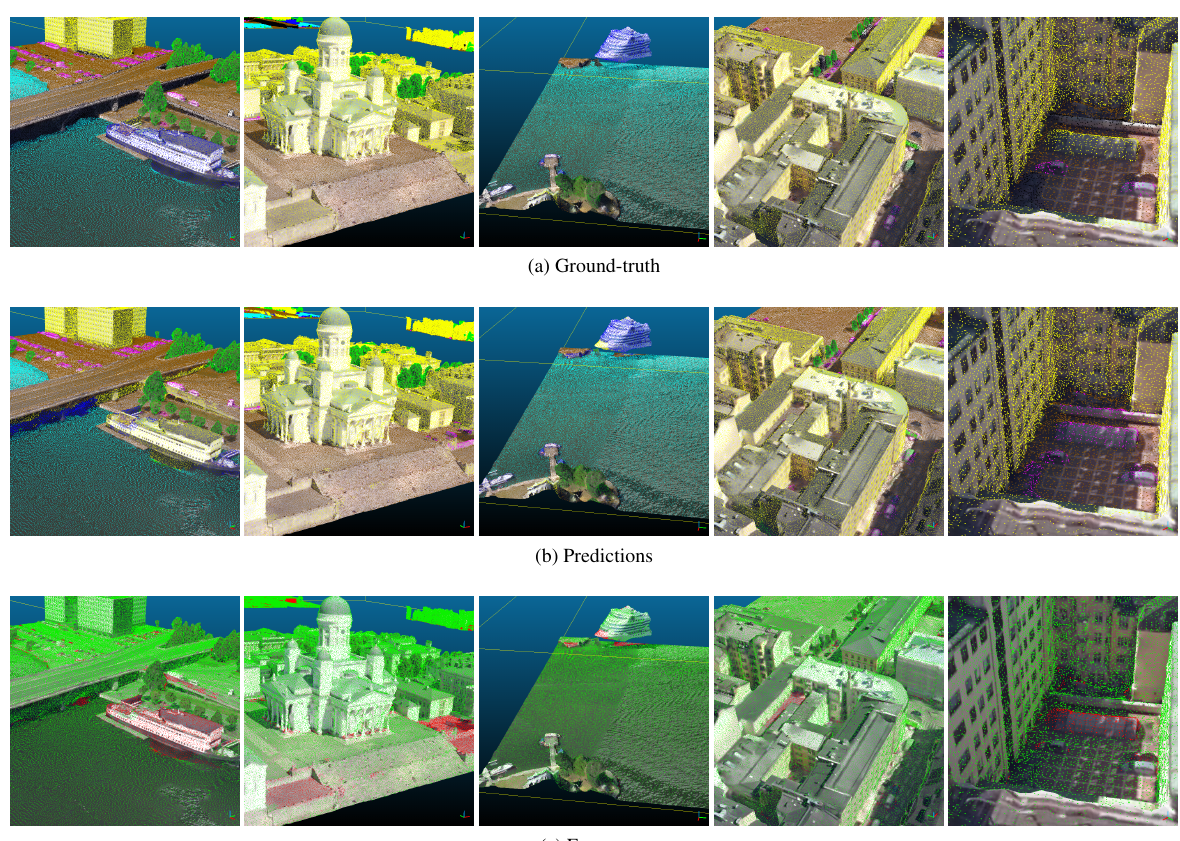
Figure 6. Results obtain with Poisson disk sampling, r = 0 . 4 , RGB and 10240